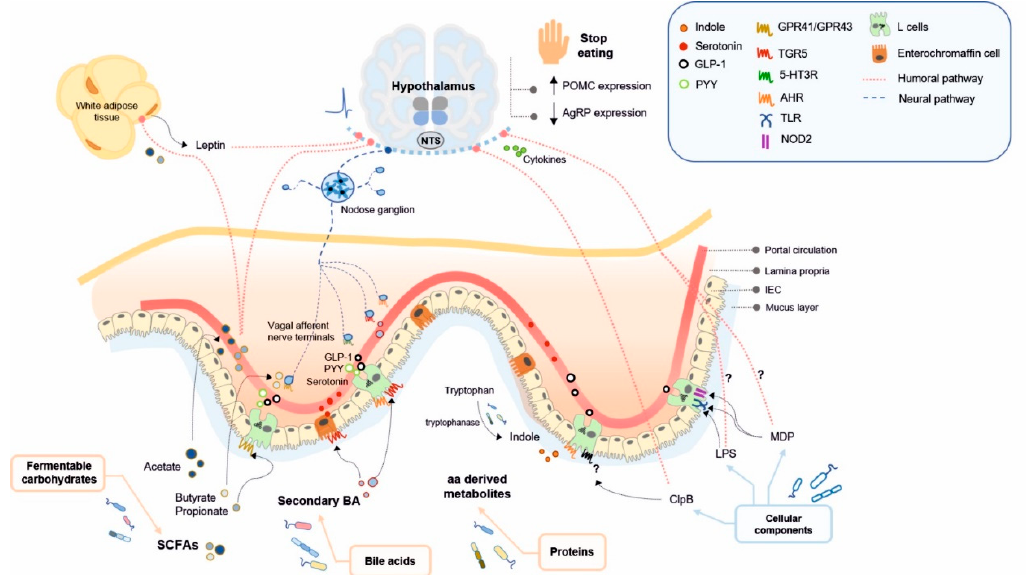
Figure 1. Bacterially produced metabolites from dietary nutrients and structural components of non-dietary origin modulate food intake in the brain (hypothalamus) through humoral and/or enterodocrine and neural signalling pathways. Here, we represent the pathways by which bacterial metabolites and non-dietary bacterial components (LPS, MDP and ClpB) induce an anorexigenic response in postprandial periods and a long-term food intake control. 5-HT3R, 5-hydroxytryptamine type 3 receptor; aa, amino acid; AgRP, agouti gene-related peptide; AHR, aryl hydrocarbon receptor; BA, bile acids; ClpB, caseinolytic peptidase B; GLP-1, glucagonlike peptide-1; GPR41/FFAR3, free fatty acid receptor 3; GPR43/FFAR2, free fatty acid receptor 2; IEC, intestinal epithelial cells; LPS, lipopolysaccharide; MDP, muramyldipeptide; NOD2, Nucleotide-binding oligomerization domain 2; NTS, nucleus tractus solitarius; PYY, peptide YY; POMC, proopiomelanocortin; SCFA, short-chain fatty acids; TGR5, takeda G protein-coupled receptor 5; TLR, Toll-like receptor.